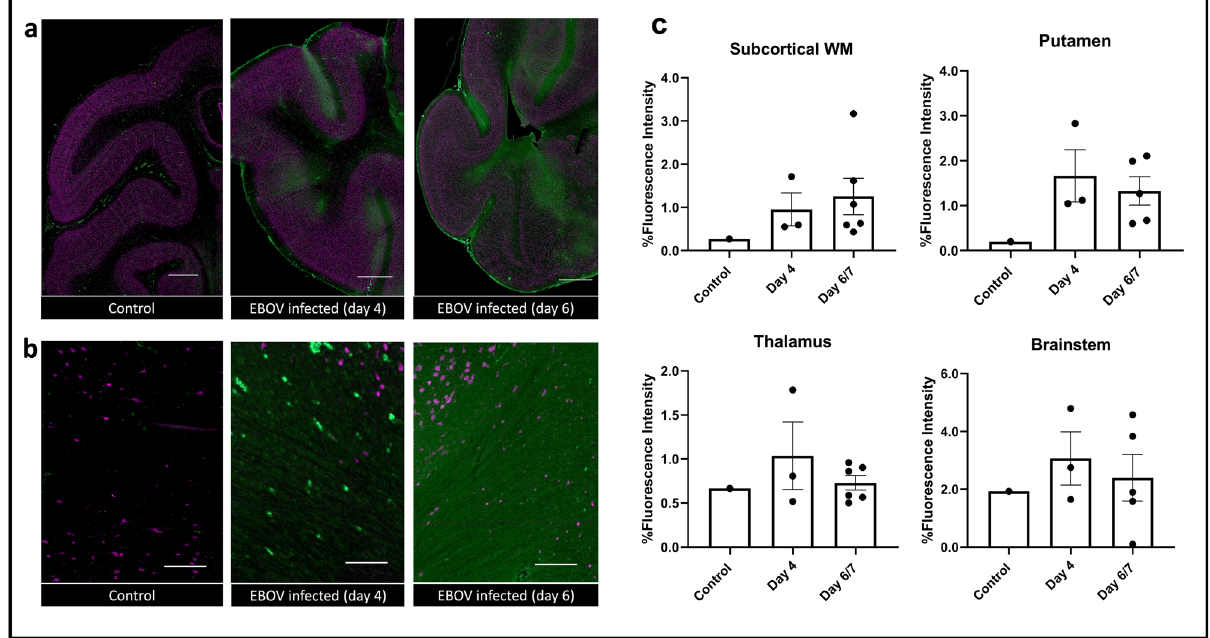
Fig. 4 Multiplex fl uorescence immunohistochemistry showing extravascular albumin leakage in the infected animal brains. a Low-magni fi cation images show patchy increased staining for albumin (green) mainly in the subcortical white matter of infected animals compared to a control animal, increasing on day 6 compared to day 4 post inoculation. Neurons are stained in purple (NeuN). Scale bar = 2 mm, magni fi cation 3%. b Extravascular staining for albumin in infected animals is better seen on higher magni fi cation images of the gray matter/white matter junction. Scale bar = 150 µ m, magni fi cation 50%. c Quanti fi cation of Albumin immuno fl uorescent staining in the subcortical white matter, putamen, thalamus and brainstem show increased percent fl uorescence intensity in the infected animals compared to control ( n = 10 animals). Data are presented as mean values + / − SEM. Source data are provided as a Source Data fi le.